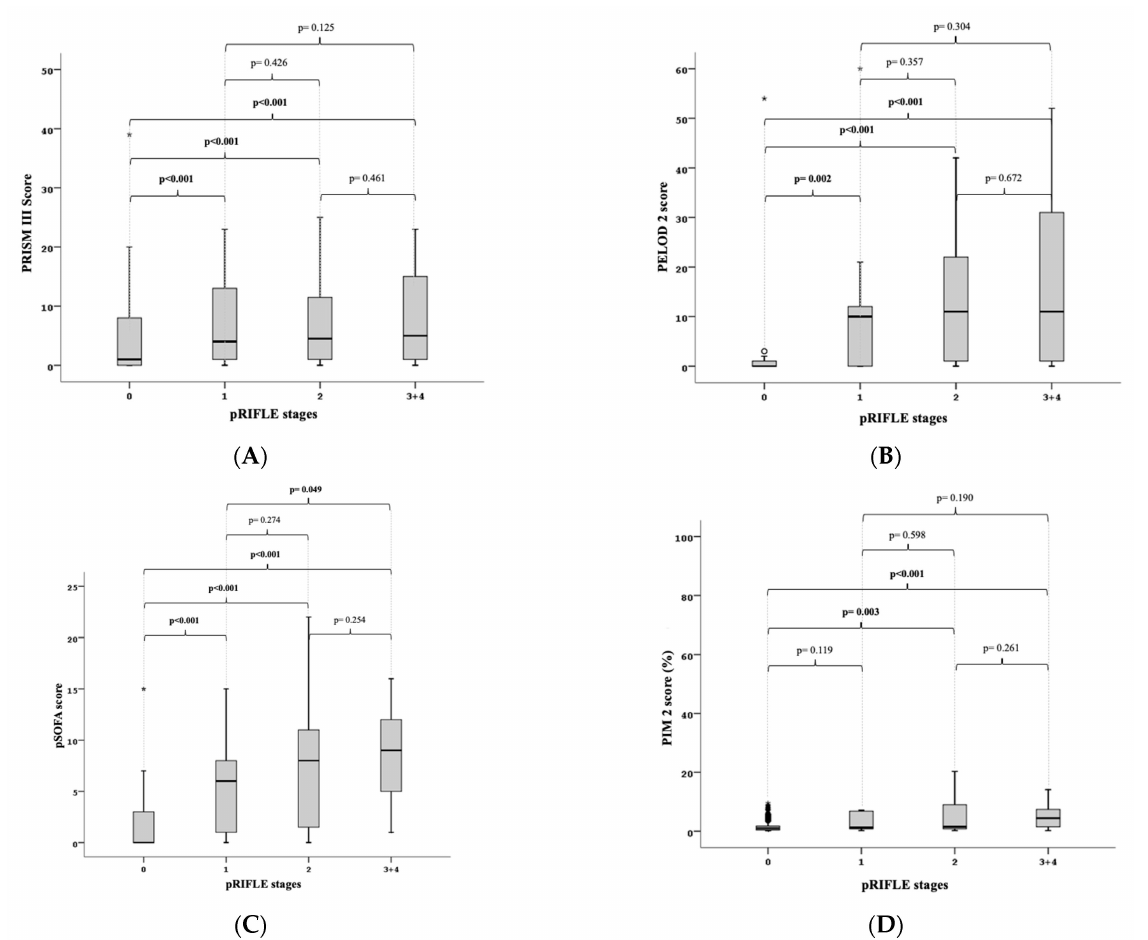
Figure 2. ( A ) pRIFLE stages and PRISM III scores: According to the pRIFLE criteria, there was no significant difference between the risk stage ( p = 0.076) and patients without kidney injury when the stages of renal injury were compared with the medians of the PRISM III score. Patients with and without renal injury were significantly different from each other in the injury ( p = 0.004) and failure plus loss ( p = 0.008) stages. The stages of risk and injury ( p = 0.878), risk and failure plus loss ( p = 0.616), and injury and failure plus loss ( p = 0.620) did not significantly differ from one another. ( B ) pRIFLE stages and PELOD 2 scores: According to the pRIFLE criteria, there was a significant difference between patients without kidney injury and patients with kidney injury in the risk ( p = 0.002), injury ( p < 0.001), and failure plus loss ( p < 0.001) stages when the stages of renal injury were compared with the medians of the PELOD-2 score. The stages of risk and injury ( p = 0.357), risk and failure plus loss ( p = 0.304), and injury and failure plus loss ( p = 0.672) did not significantly differ from one another. ( C ) pRIFLE stages and pSOFA scores: According to the pRIFLE criteria, there was a significant difference between patients without kidney injury and patients with kidney injury in the risk ( p < 0.001), injury ( p < 0.001), and failure plus loss ( p < 0.001) stages when the medians of the kidney injury stages and the pSOFA score were compared. The risk and injury stages ( p = 0.274) and the injury and failure plus loss stages ( p = 0.254) did not significantly differ from one another, whereas the risk and failure plus loss stages ( p = 0.049) did. ( D ) pRIFLE stages and PIM 2 scores: According to the pRIFLE criteria, there was no significant difference between patients without kidney injury and patients with kidney injury in the risk ( p = 0.119) stage when the stages of renal injury were compared with the medians of the PIM-2 score. The difference between the patients with and without renal injury was statistically significant in both the injury ( p = 0.003) and failure plus loss ( p < 0.001) stages. The stages of risk and injury ( p = 0.598), risk and failure plus loss ( p = 0.190), and injury and failure plus loss ( p = 0.261) did not significantly differ from one